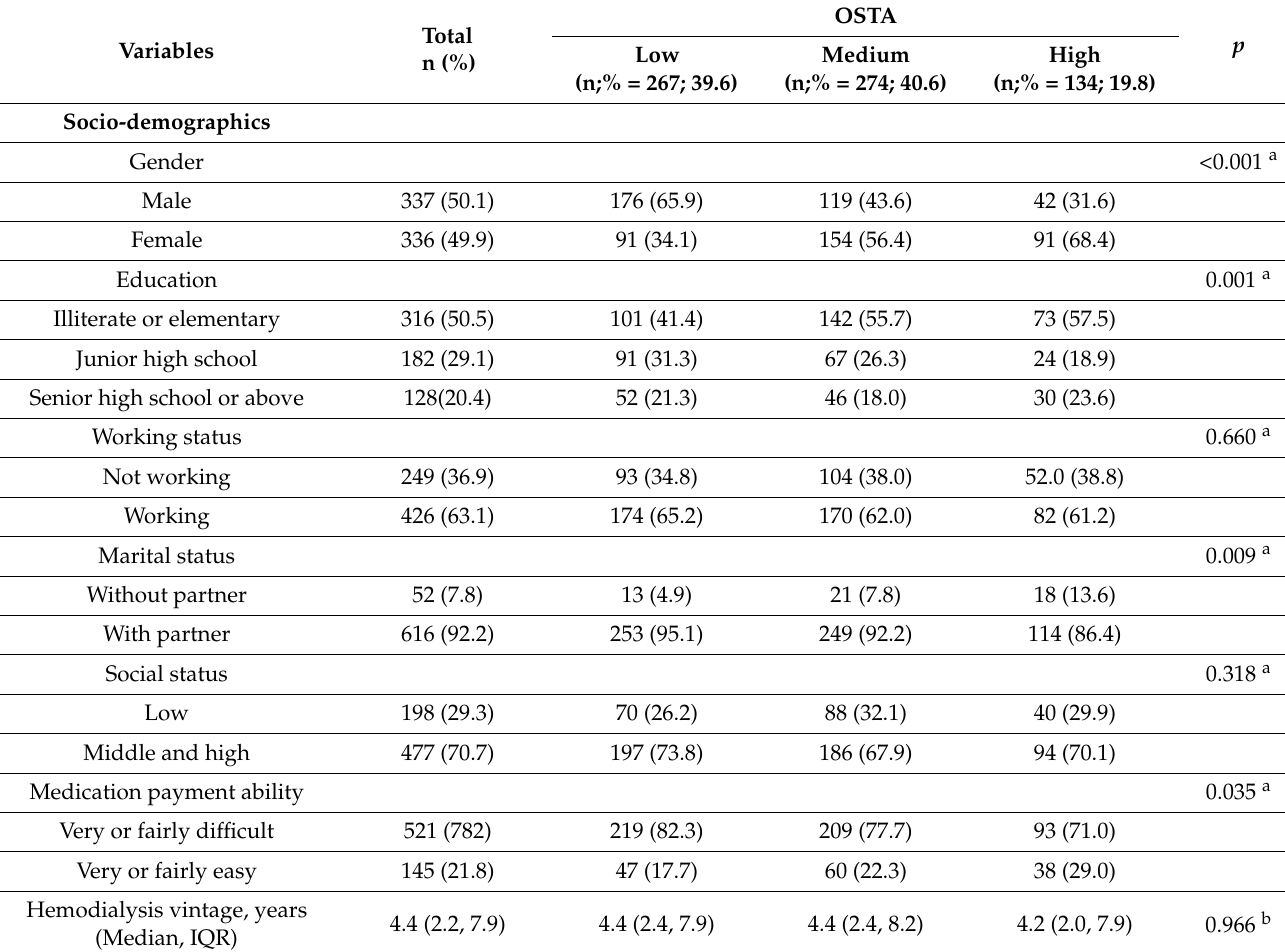
Table 1. Patients’ characteristics and OSTA (n =